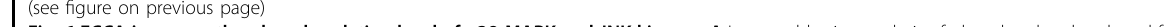
Fig. 6 ECCA increases the phosphorylation level of p38-MAPK and JNK kinases. A Immunoblotting analysis of phosphorylated and total forms of JNK, p38-MAPK, and ERK proteins in UACC62 cells treated with or without ECCA at the indicated concentrations and times. Red and blue arrows indicate the upregulated expression of p-JNK and p-p38-MAPK, respectively. GAPDH is a housekeeping gene used as a loading control. B , C Quanti fi cation of the relative levels of phosphorylated JNK ( B ) and p38 ( C ) in A , which shows relative fold change to the respective control group, indicated by a dashed line as 1, after each phosphorylation protein was normalized to the corresponding total protein band (JNK or p38). D Immunoblotting analysis of phosphorylated and total forms of JNK, p38-MAPK, p53, and cleaved and total forms of Caspase9 and Caspase3 proteins in UACC62 cells treated with different conditions (DMSO (control), SB202190, JNK-IN-8, ECCA, ECCA + SB202190, ECCA + JNK-IN-8) at 24 h. Red, blue, and green arrows indicate the downregulated expression of p-JNK, p-p38-MAPK, and p-p53, respectively. Black and yellow arrows indicate the upregulated expression of C-Caspase9 and C-Caspase3. GAPDH is a housekeeping gene used as a loading control. E – I Quanti fi cation of the relative levels of phosphorylated JNK ( E ), p38 ( F ), p53 ( G ), cleaved Caspase9 ( H ), and Caspase3 ( I ) in D . J Wild-type (control) and p53-ko UACC62 cells were treated with different conditions: DMSO (control), ECCA, ECCA + SB202190, ECCA + JNK-IN-8. Cells at 12 h after treatment were collected and analyzed by the CCK8 assay for cell viability. All experiments were carried out three times, and error bars represent means ± SD; P values are indicated with “ * ” , ** indicates P < 0.01, *** indicates P < 0.005 when comparing the ECCA-treated group with the control group in B and C and comparing the corresponding two groups indicated by lines in ( E – J ) by Student ’ s t